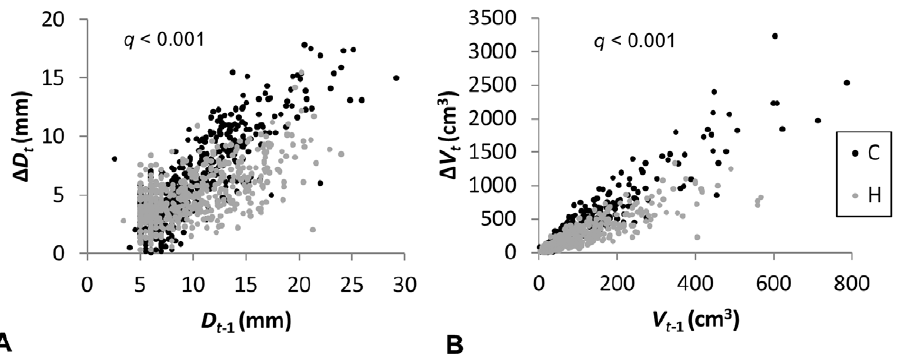
Figure 5. The interaction between treatment and size of the trees at the end of the previous ( t 2 1) growing season for predicting the current year ( t ) increment in control (C) and humidified (H) plots: a) stem diameter ( D ), b) stem volume ( V ). Points represent individual measurements across three years of the experiment.